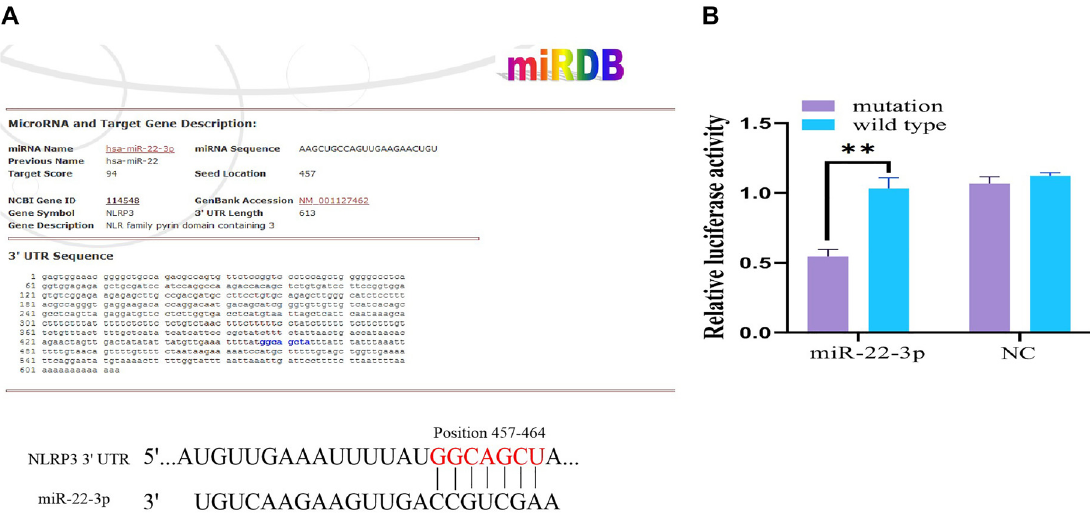
Figure 4: (A) The predicted binding sites of miR-22-3p on 3 ′ -UTR of NLRP3 mRNA by MirDB and miRWalk (MirDB: http://www.mirdb.org/, miRWalk:http://mirwalk.umm.uni-heidelberg.de/).(B)miR-22-3psigni fi cantlyinhibitedluciferaseactivitycomparedwiththemutantbinding sites. The asterisk indicates thatthe difference is statistically signi fi cant (p-value